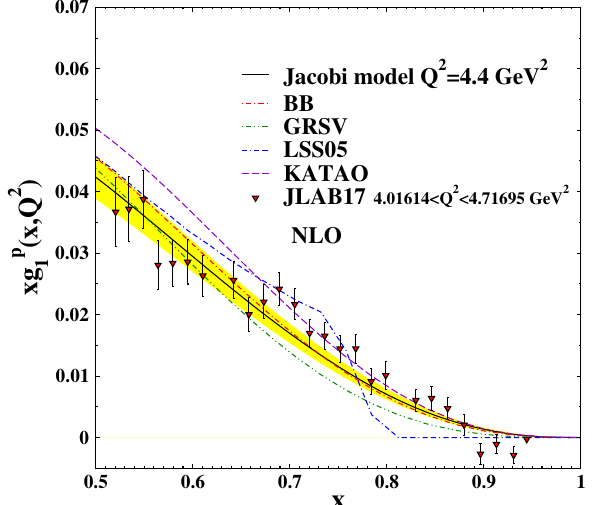
Fig. 4 As in Fig.2 but at Q 2 = 4 . 4 GeV 2 and in a shorter range of x which is corresponding the available data